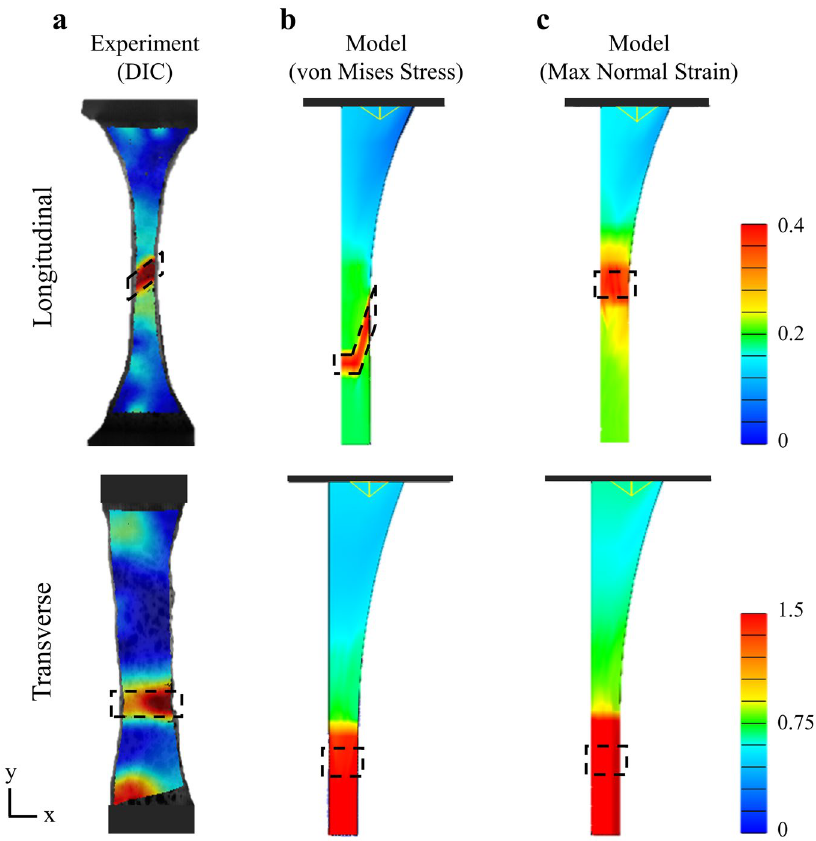
Figure 4. Normal Lagrange strains ( E yy ) from experiments and FE models for longitudinal and transverse specimens. ( a ) The experimental tear pattern and strains in the tear region (ROI) measured with DIC were compared to model predictions using ( b ) von Mises stress damage criterion, and ( c ) maximum normal strain damage criterion. ROI are shown by the dashed black